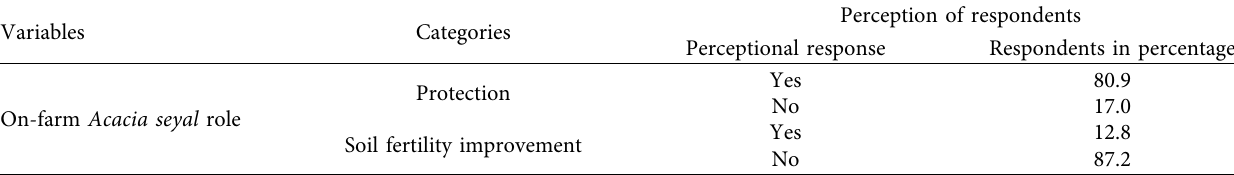
Table 8: Perception of respondents on service role of Acacia seyal at cropland.